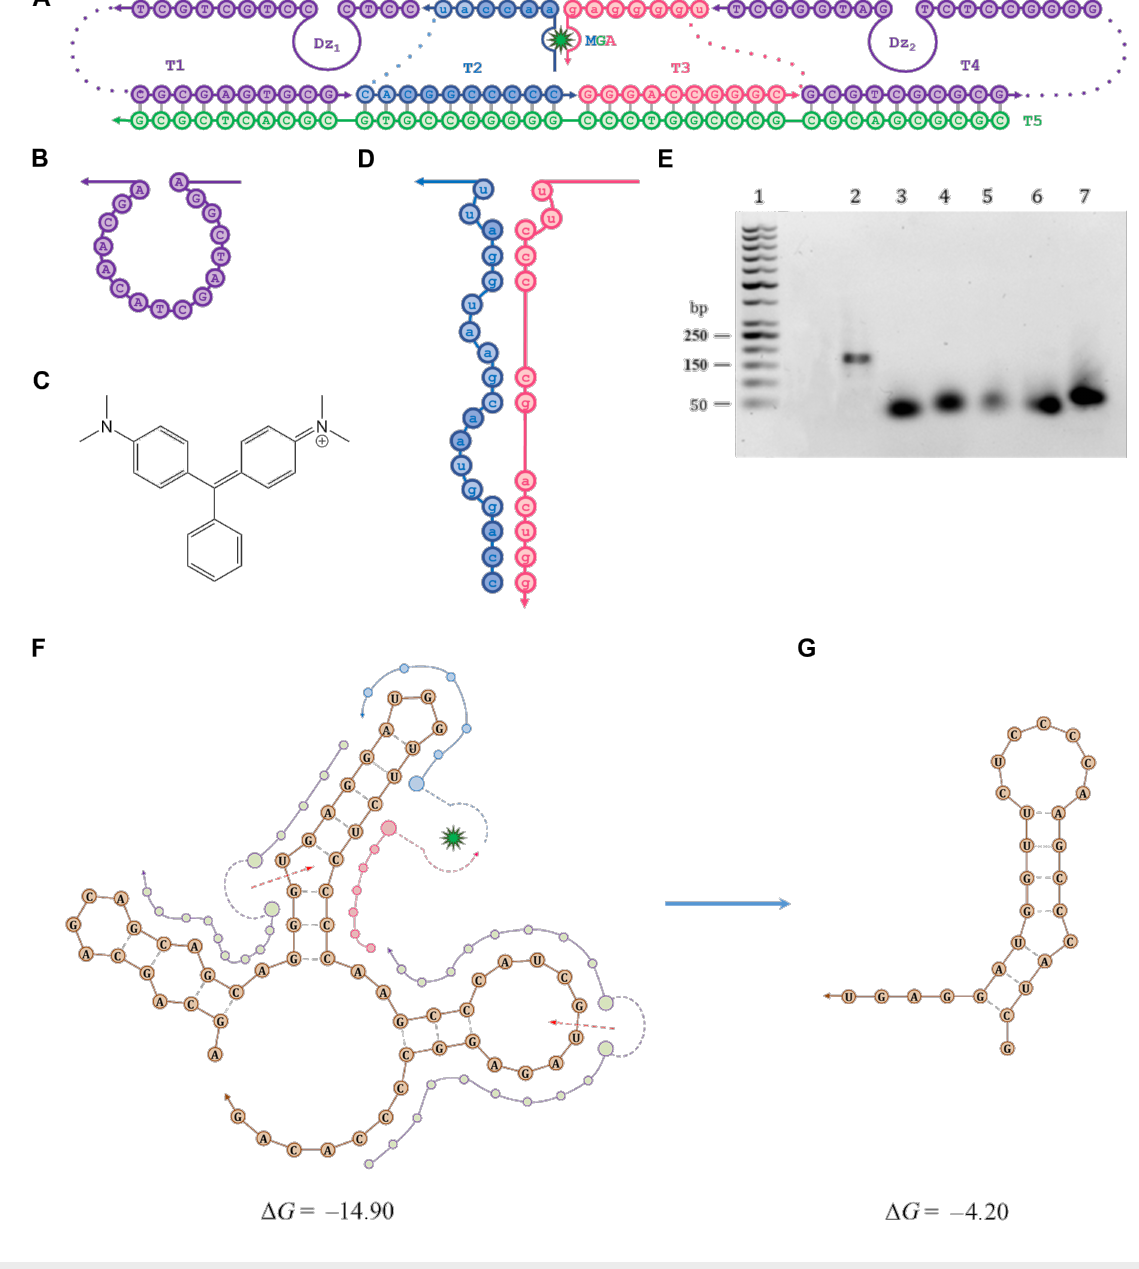
Figure 1: SDFS main components and its work model. A) Schematic representation of the SDFS structure. Dotted lines indicate hexaethylene glycol linkers in T1 and T4, and polythymidines linker in T2 and T3; Dz1 and Dz2 – deoxyribozyme sequences. B) The detailed structure of the Dz catalytic core cited by Silverman 2016 [19]; the green star indicates a malachite green dye molecule. C) Malachite green dye chemical structure. D) Detailed malachite green split aptamer structure cited by Kolpaschikov 2005 [20]. E) Confirmation of SDFS assembly by using agarose gel electrophoresis; lane 1: DNA ladder; lane 2: assembled SDFS; lanes 3–7: strands T1–T5, respectively. F) An initial 60-nt fragment of AR mRNA (60-AR_RNA); color lines indicate the possible orientation of the SDFS chains around the RNA structure; red arrows with dotted loops indicate the assumed cleavage sites. G) A short 27-nt fragment resulting from the 60-AR_RNA cleavage. Prediction of the RNA secondary structure with the folding energy before and after cleavage was performed by MFold open source [21].